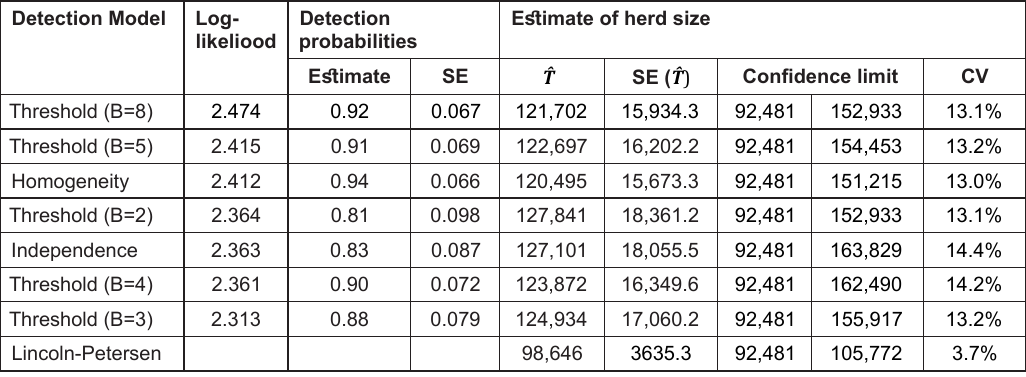
Table 5. Rivest model estimates and LP estimate for the Bluenose-East 2010 survey 1 .